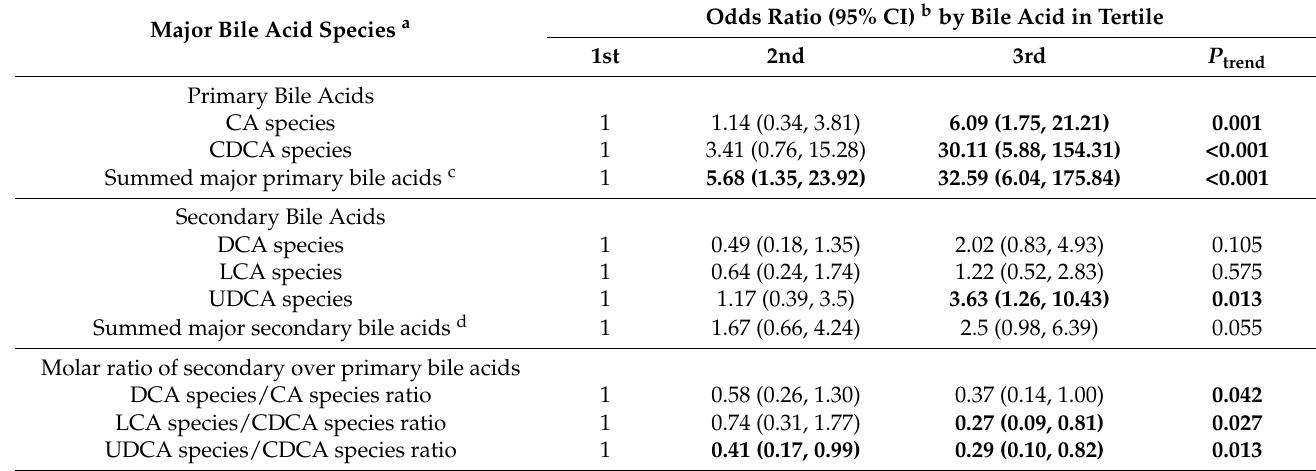
Table 3. Major primary and secondary individual bile acids and the molar ratios of secondary over primary bile acids in relation to risk of developing hepatocellular carcinoma, The Singapore Chinese Health